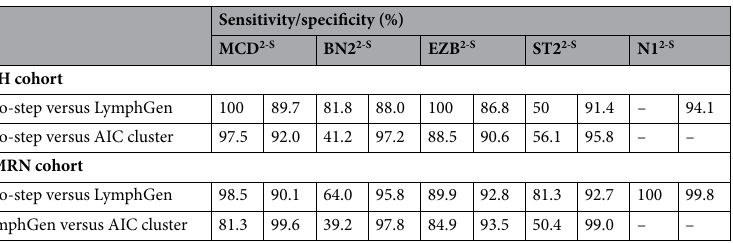
Table 2. Sensitivity and specificity analysis comparing the three classifiers in the Puerta de Hierro (PdH) and HMRN